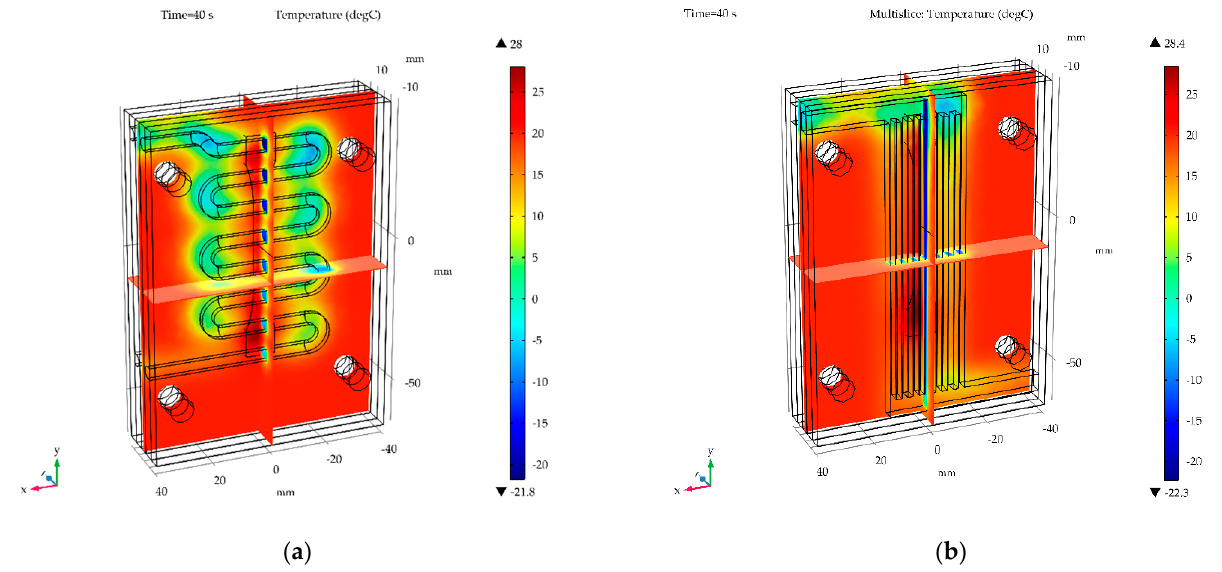
Figure 25. The temperature distribution in wax injection mold for air cooled with flow rate of 0.001 kg/s with: ( a ) rounded channels, ( b ) finned channels. 0.001 kg/s with: ( a ) rounded channels, ( b ) finned